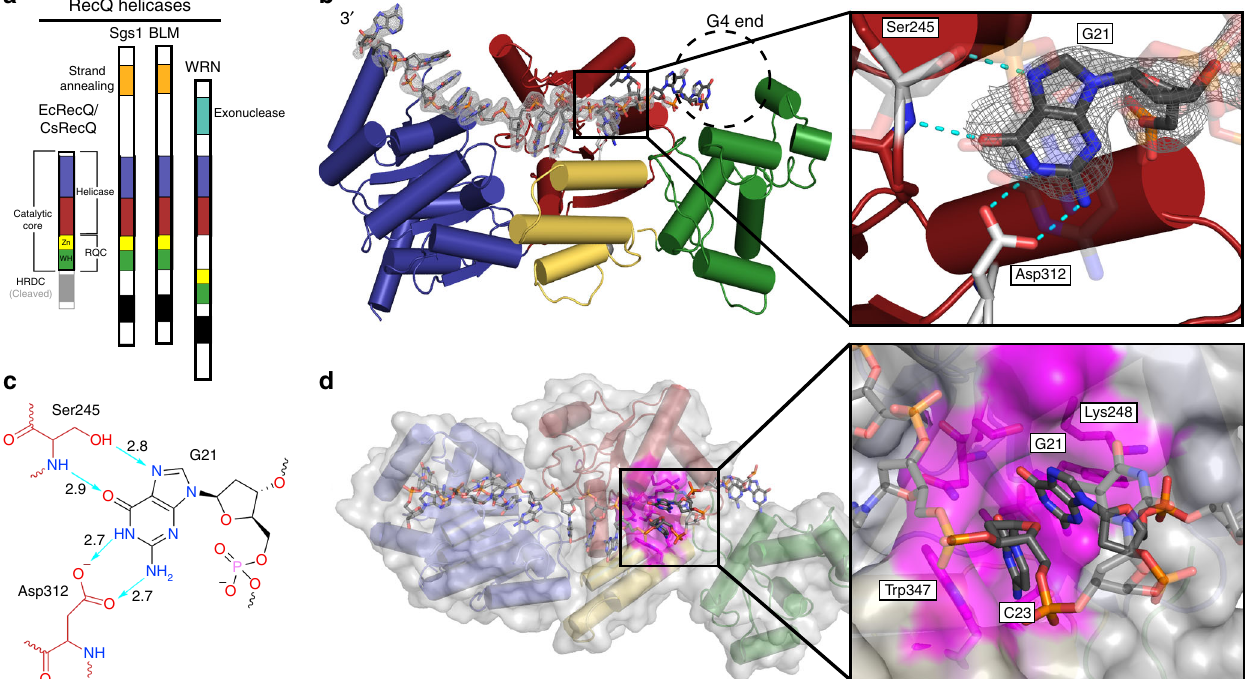
Fig. 1 The guanine-speci fi c pocket of the CsRecQ helicase. a Domain schematic representation of RecQ helicase family. RecQ comprises two RecA-like helicase folds (blue and red) and a C-terminal domain (RQC). The RQC contains a Zn 2 + -binding domain (Zn, yellow), a winged-helix domain (WH, green) and a helicase and RNaseD c-terminal domain (HRDC, gray). The HRDC has been removed in the RecQ catalytic core. b Crystal structure of CsRecQ bound to resolved G4 DNA. Domain colors correspond to a . F o – F c omit electron density contoured at 2.0 σ is shown. The expected location of the G4 is highlighted. (Insert) The GSP in RecQ binds the fl ipped guanine with high speci fi city. Hydrogen bonds are represented by dashed lines. c Ligand interaction diagram of the GSP/guanine interface. Bond distances in Å are shown for the hydrogen bonds (teal). Residues from RecQ are red while the guanine is in black. d Surface representation of the CsRecQ bound to the resolved G4 with the GSP colored in magenta. (Insert) The fl ipped G21 is stabilized by hydrophobic interactions and base stacking with